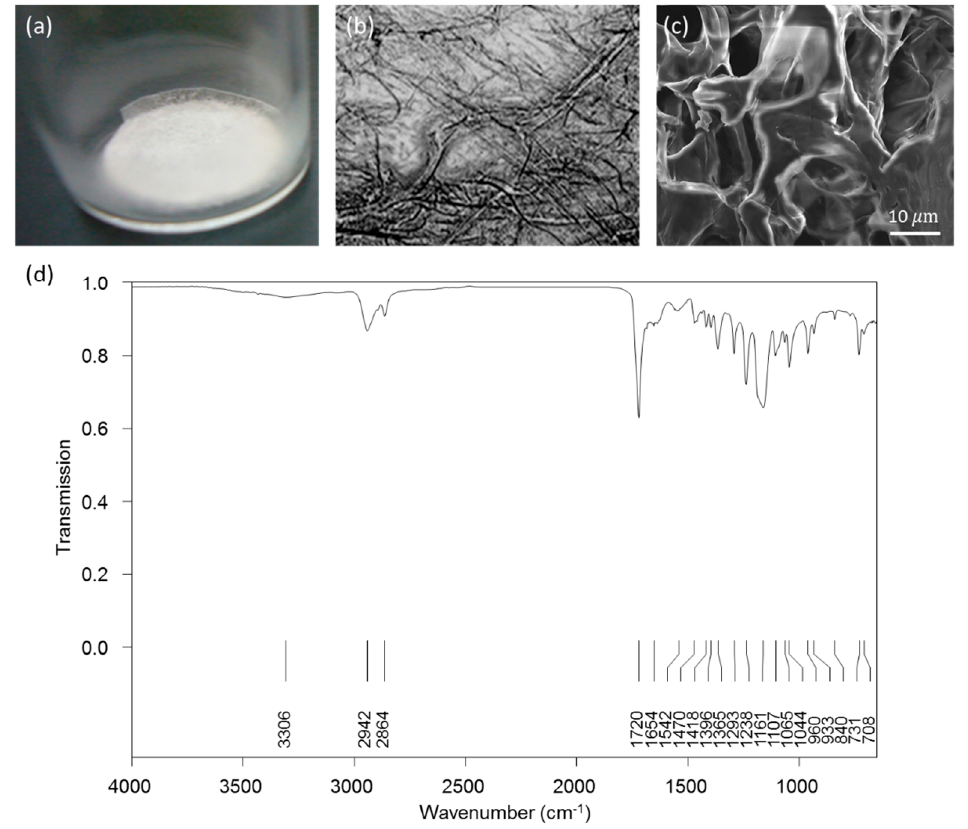
Figure 2. The morphology and characteristics of the gelatin scaffold. ( a – c ) Appearance of the scaffold upon macroscopic examination, visible light microscopy, and scanning electron microscopy, respectively; ( d ) Fourier transform infrared spectroscopic analysis.